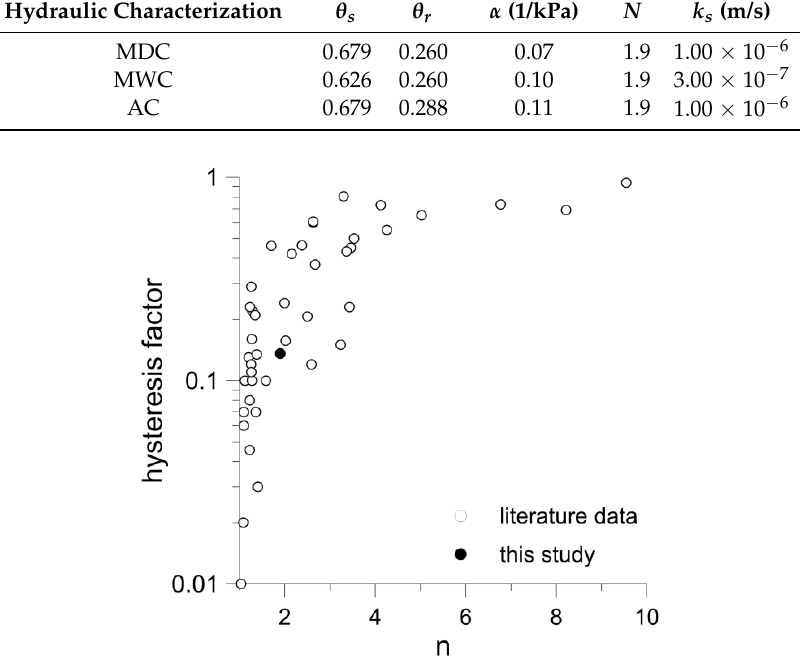
Table 1. Parameters regulating the hydraulic behavior of investigated soil under the different adopted characterizations: MDC (main drying curve), MWC (main wetting curve), and AC (average curve). Hydraulic Characterization